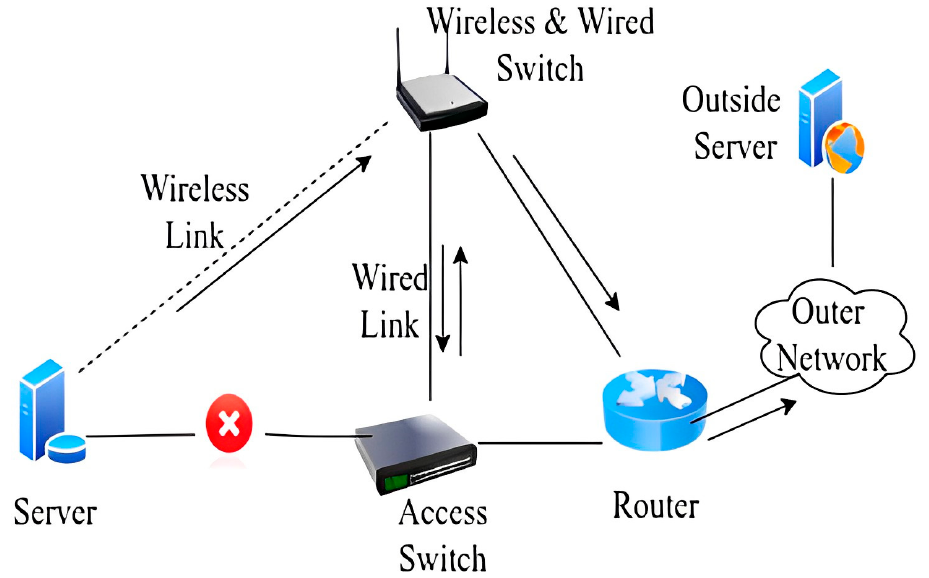
Figure 6. Scenario B [15].